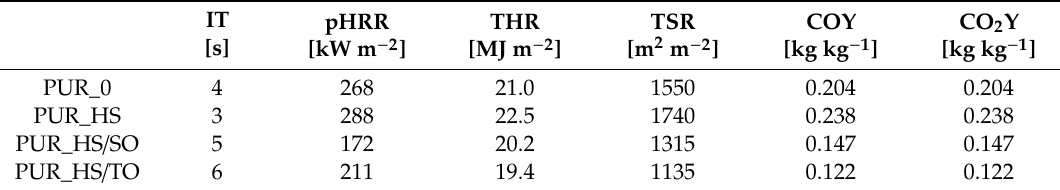
Figure 10. Cone calorimeter results: ( a ) pHRR, ( b ) TSR, ( c ) COY and ( d ) CO 2 Y. Table 6. Flammability parameter measured for PUR